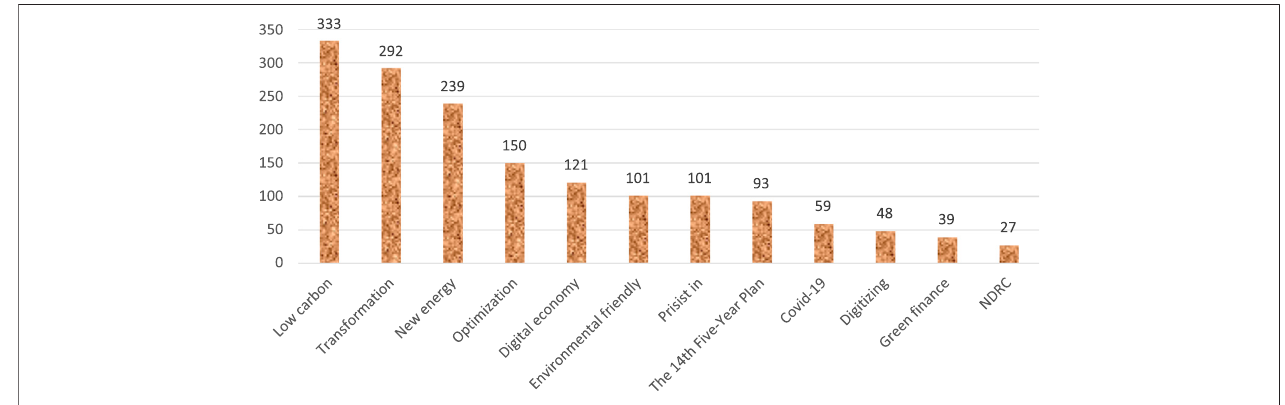
FIGURE 5 | Most mentioned keywords for “ Carbon peak, Carbon-neutral, Industry, and Adjustment ” in Weibo microposts.